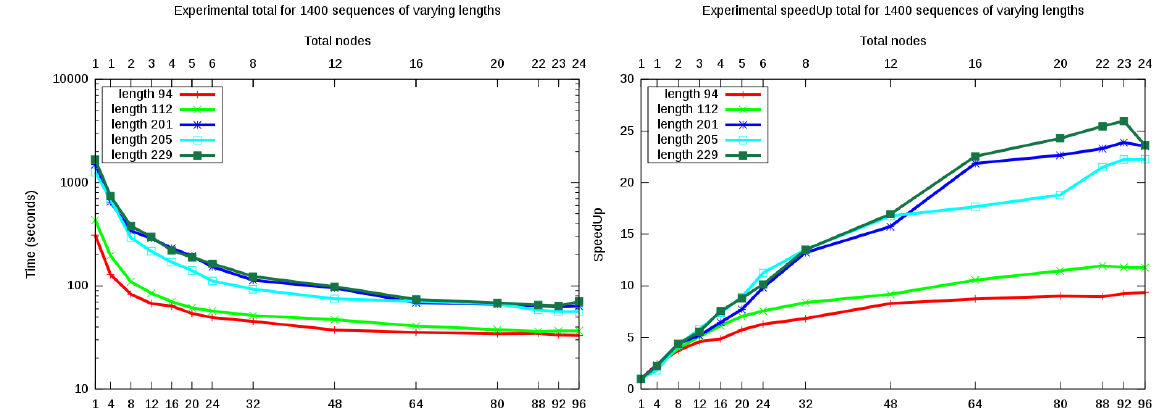
Figure 7: Total computation time and SpeedUp varying the sequence